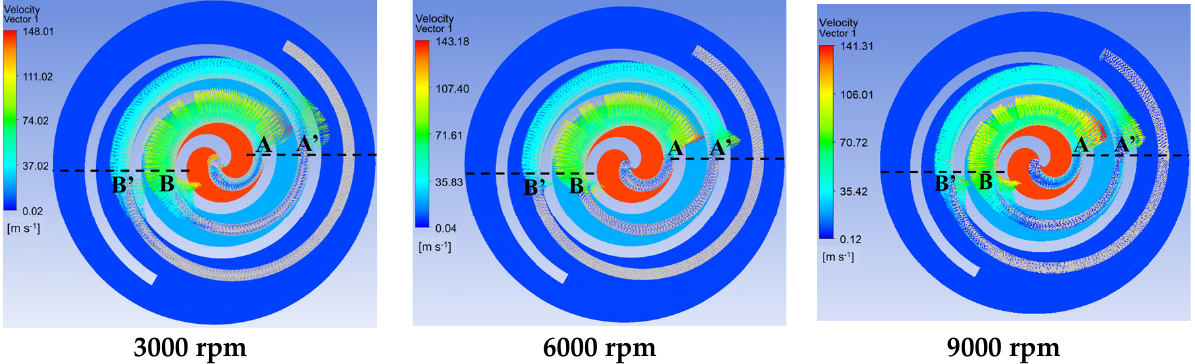
Figure 14. Velocity distribution on a cross-section of the top axial clearance domain (z = 0.005 mm).